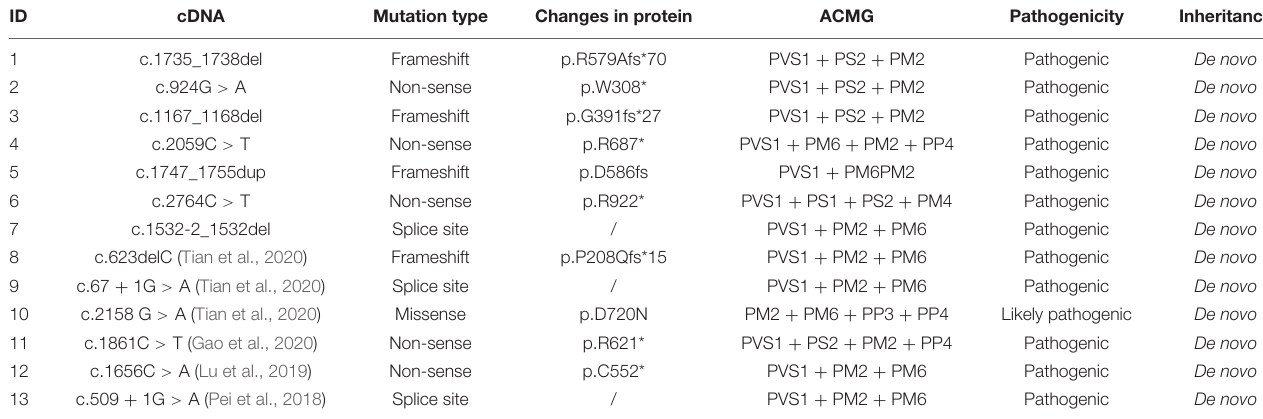
TABLE 4 | List of 13 patients with SYNGAP1 gene molecular information in